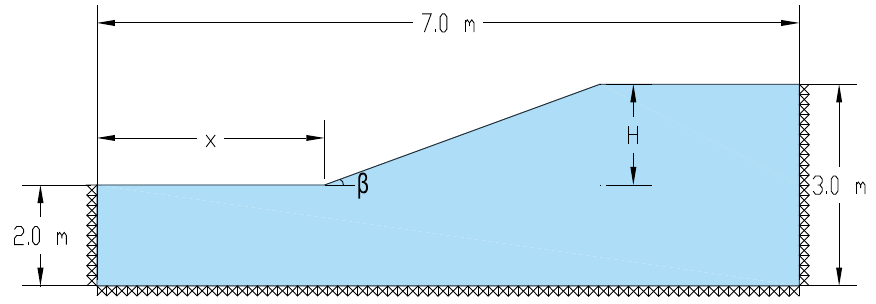
Figure 2: Schematic diagram of the analysed problem geometry.